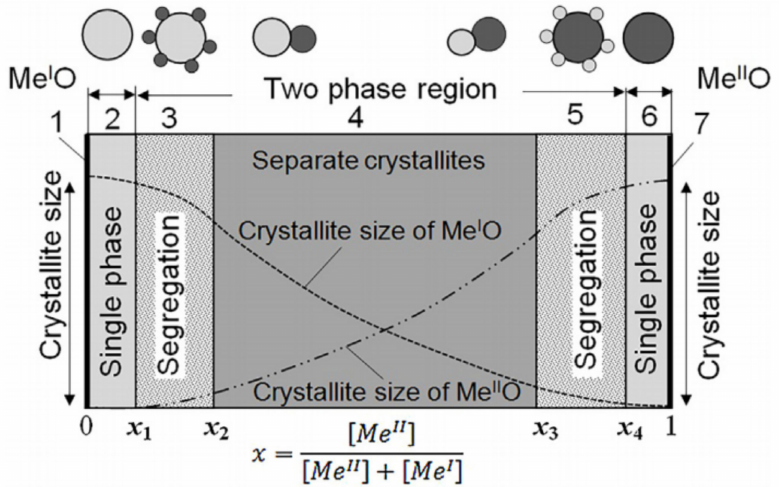
Figure 18. Scheme of mutual distribution of components in M I O − M II O nanocomposites. Possible transformation of the crystallite size and the grain structure of the major components of the nanocom- posite is also shown in the figure. x 1 and x 4 correspond to the solubility limits of Me II in Me I O and Me I in Me II O. Reprinted with permission from [60]. Copyright 2017 Elsevier. Idea from Refs. [51,241].